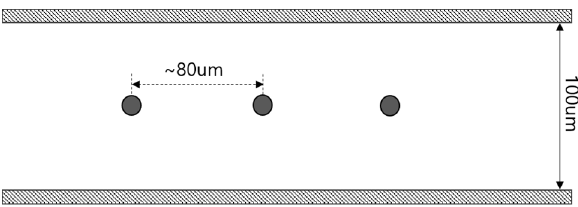
Figure 12. Interparticle distance when the concentration is n = 1.93 × 10 12 m − 3 .